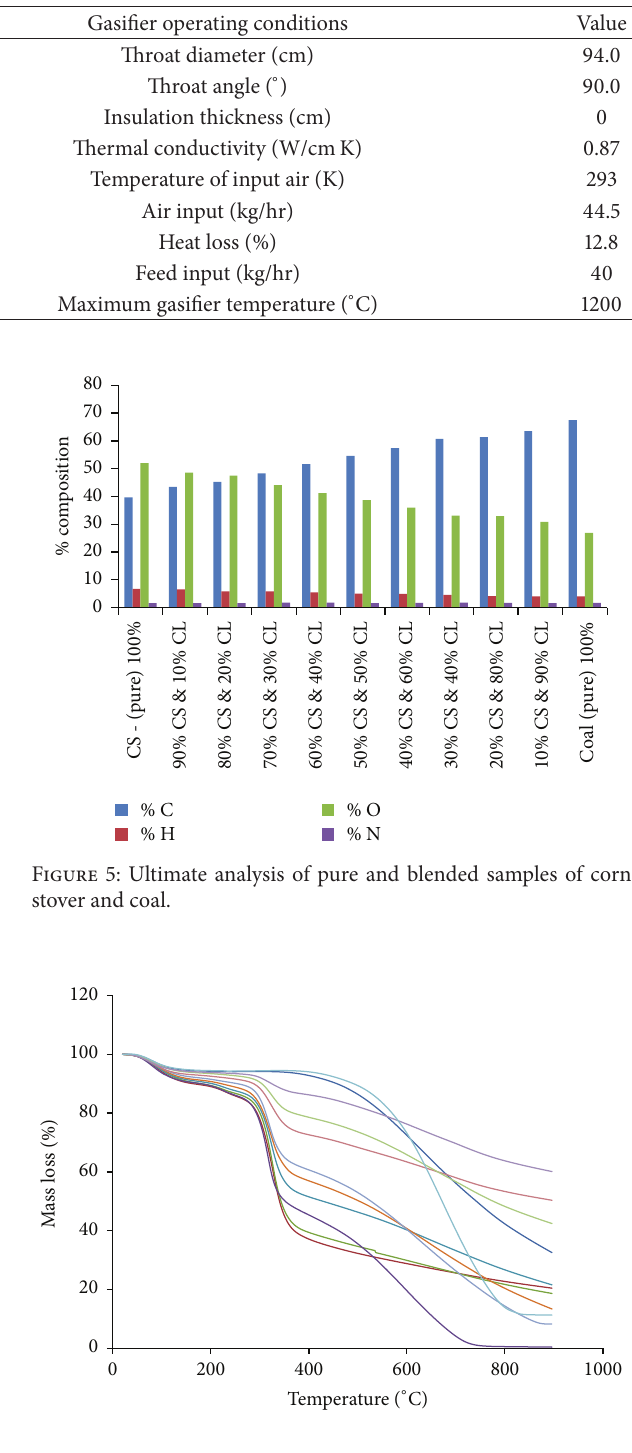
Table 1: Normal operating parameters of a downdraft gasifier [12].